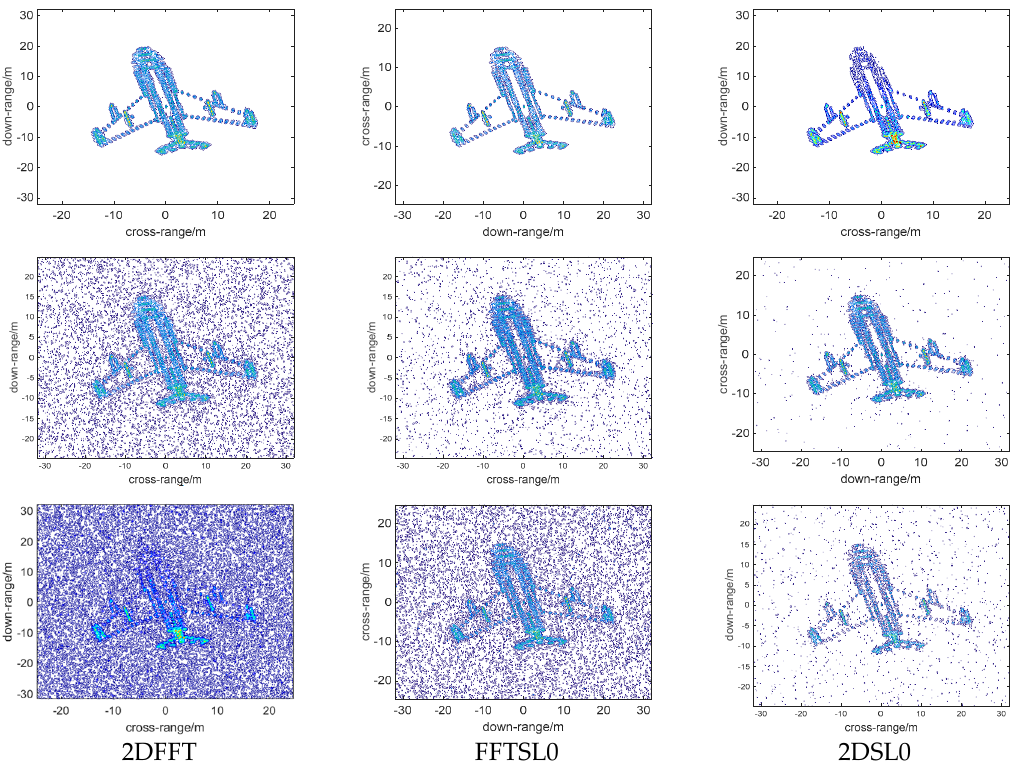
Figure 7. Bi-ISAR imaging results with different reconstruction methods under different SNRs. Column 1 represents 2DFFT images, Column 2 represents FFTSL0 images, and Column 3 represents 2DSL0 images. Row 1 represents SNR is 5 dB, Row 2 represents SNR is 0 dB, and Row 3 represents SNR is − 5 dB.